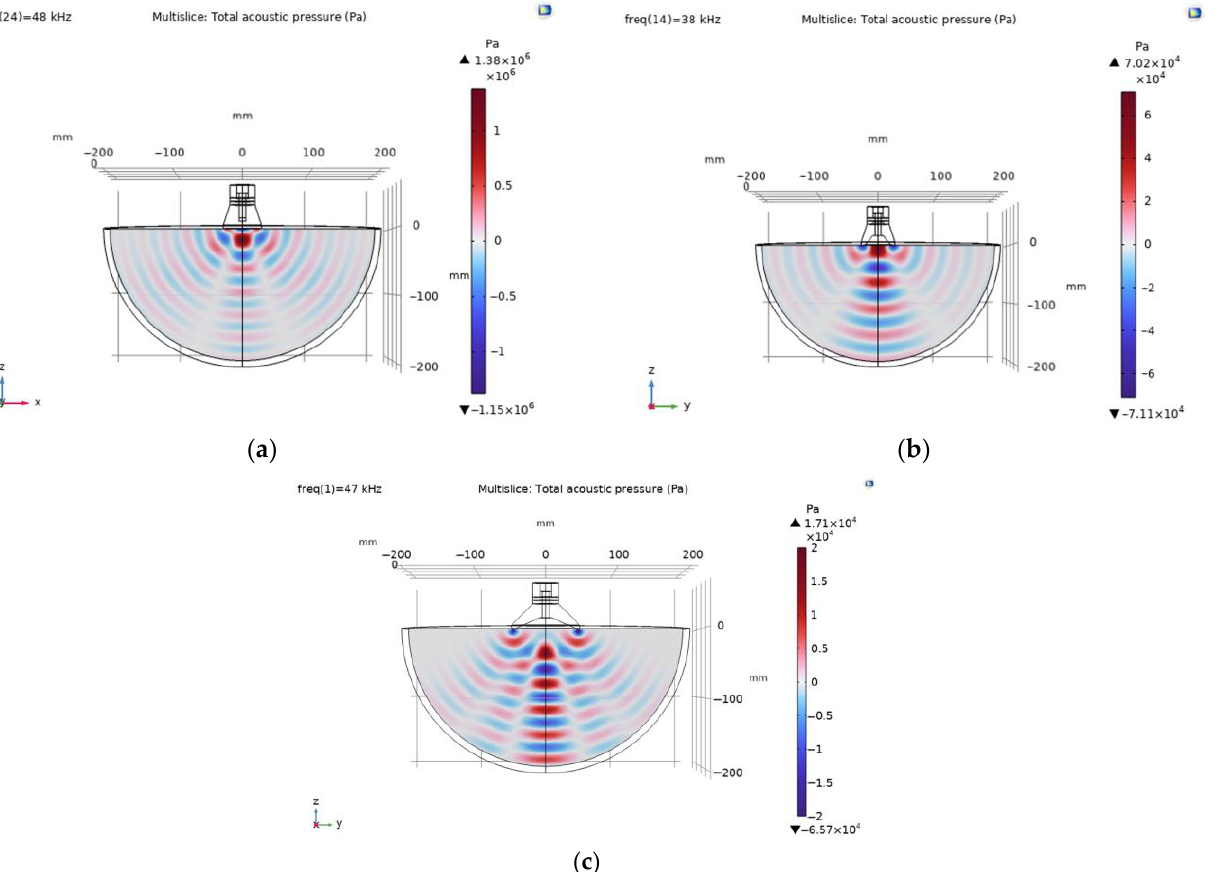
Figure 8. Propagation of acoustic field generated by piezoelectric transducer at the second mode in the muscle: ( a ) with flat surface, ( b ) with 58 mm diameter ring-shaped surface, ( c ) with 100 mm diameter ring-shaped surface.